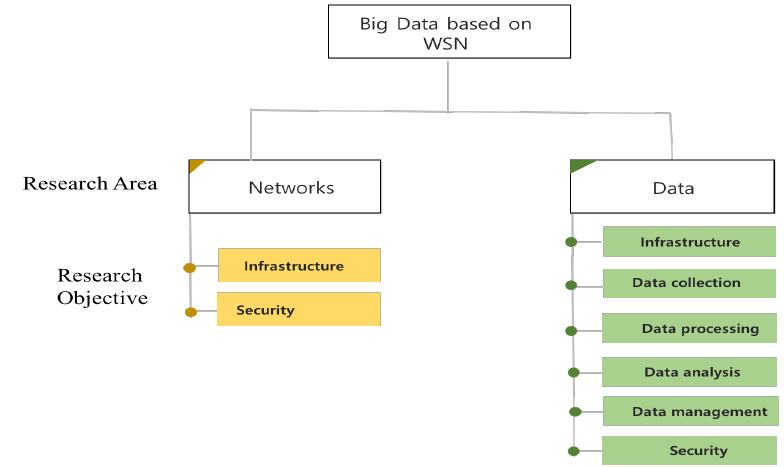
Figure 4. Classification of related